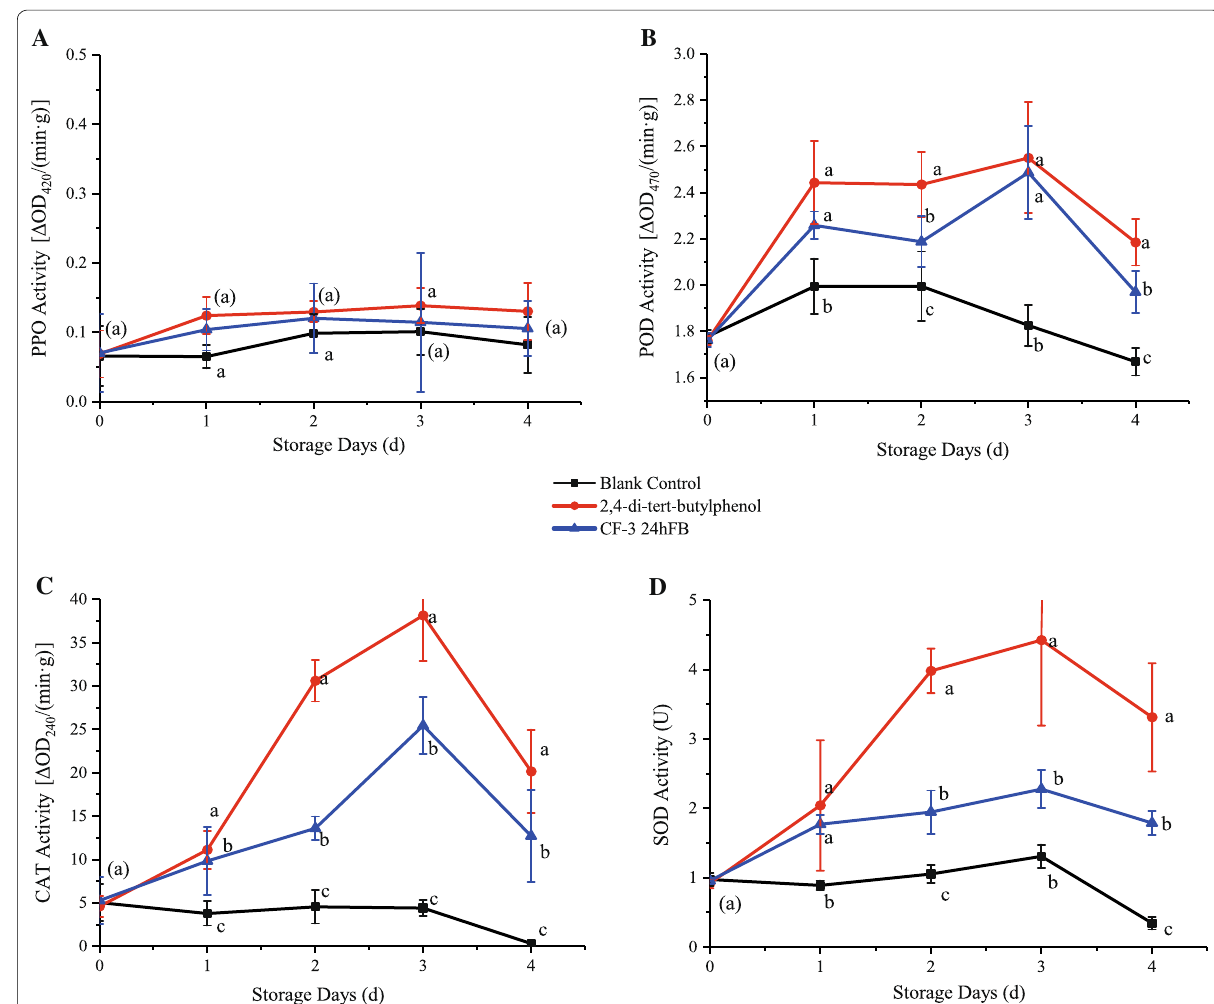
Fig. 6 Influence of different treatments on POD ( A ), PPO ( B ), CAT ( C ) and SOD ( D ) activity in vivo during storage. The mean and standard errors in the figure were taken from three replicates, and different letters indicate that different treatments in the same storage days were significantly different ( P < 0.05 ) ( POD peroxidase, PPO polyphenol oxidase, CAT catalase, SOD superoxide